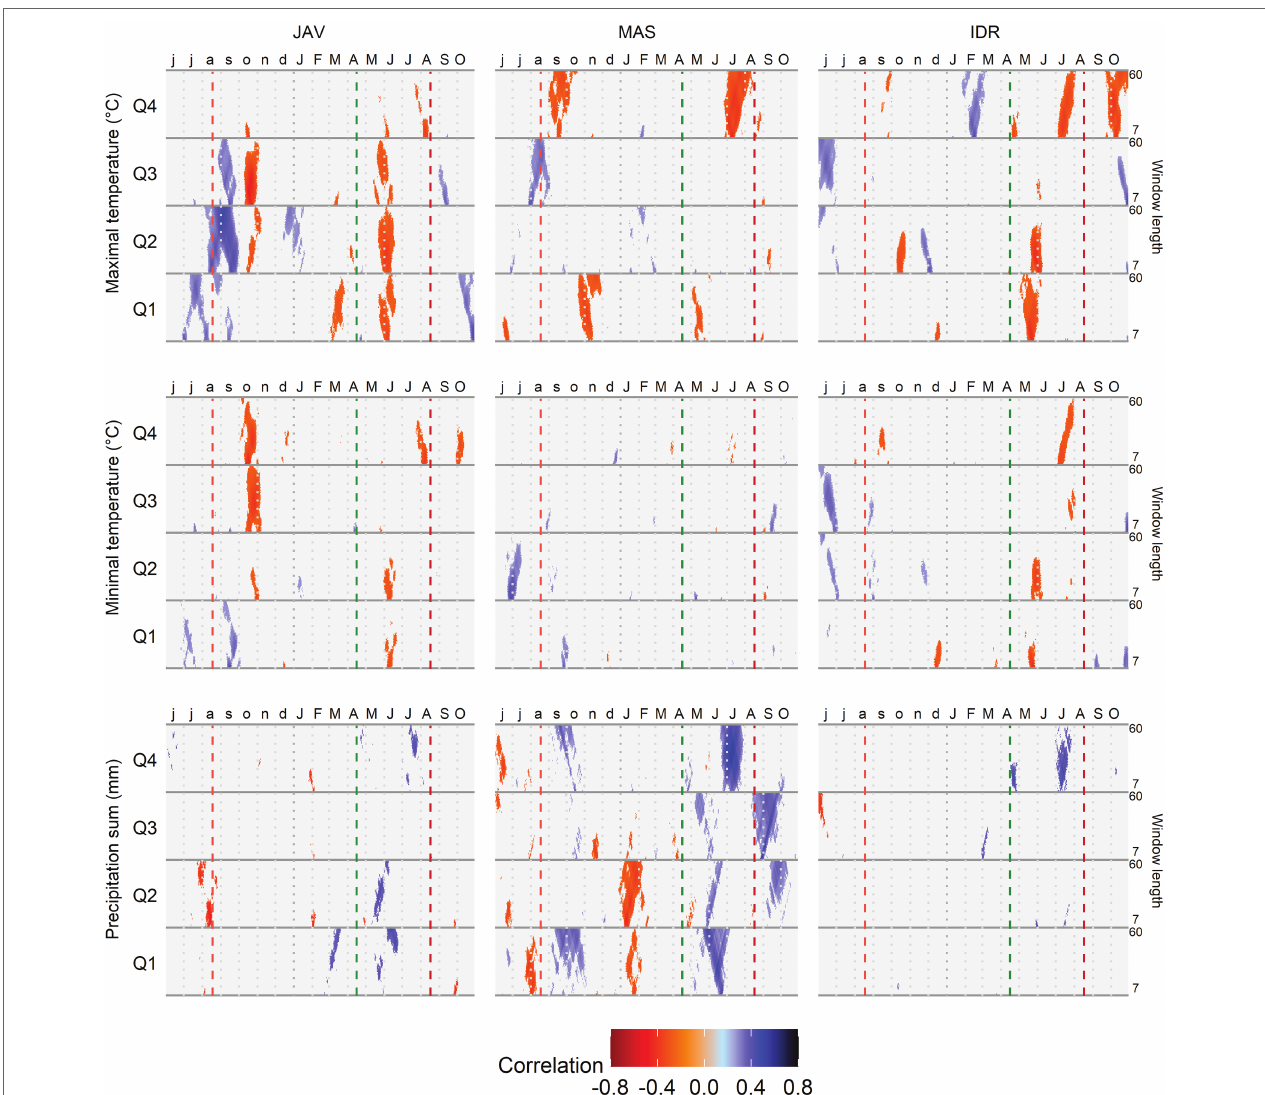
FIGURE 6 | Correlation analysis between the standardized chronologies of mean vessel area (MVA) in quarters Q1–Q4 and maximum and minimum daily temperature and daily precipitation sums at Javornik (JAV), Mašun (MAS), and Idrija (IDR) using a time window spanning between 7 and 60 days. Vertical dashed lines from left to right depict the approximate timing of the growing season based on previous data (Prislan et al., 2013): end of previous growing season (light red), start (green), and end (dark red) of current growing